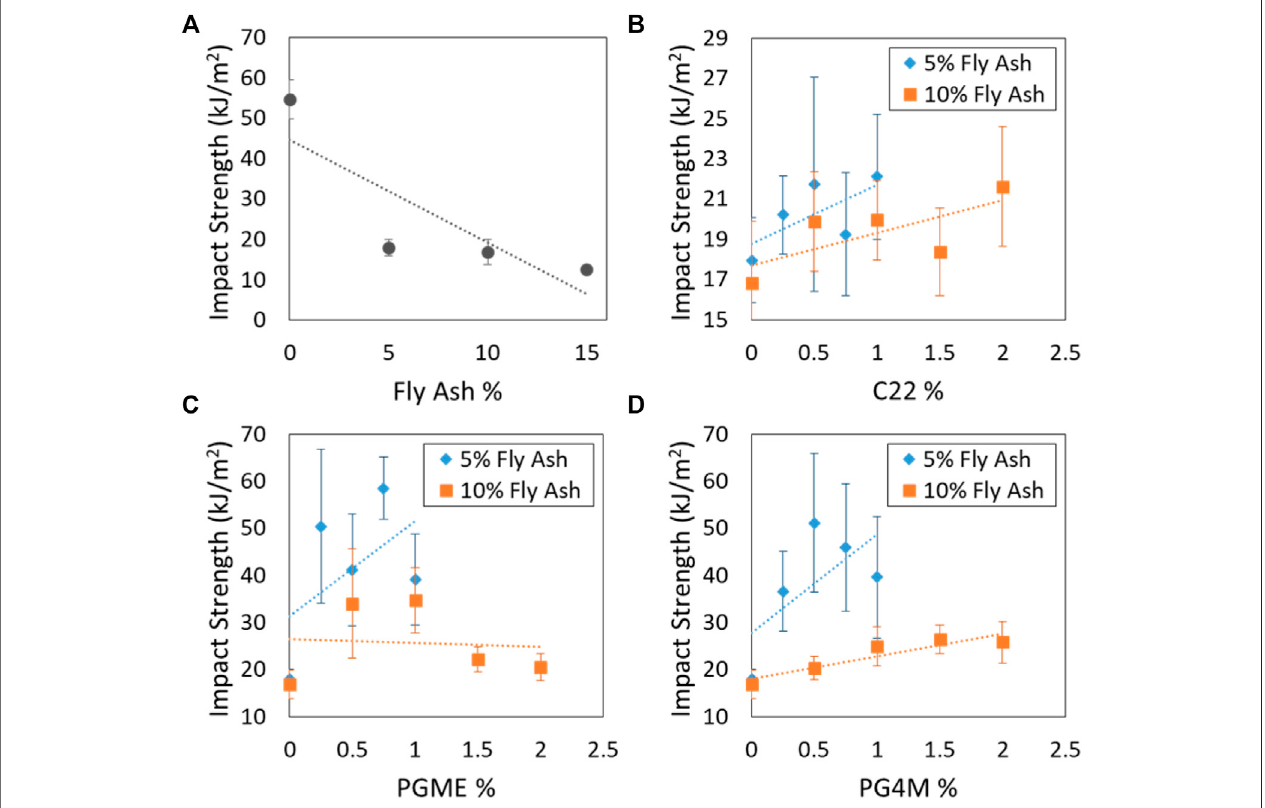
FIGURE 11 | Impact strength calculated from Charpy Impact test results (A) Fly ash blends without compatibilizer, (B) blends with C22, (C) blends with PG4M, (D) blends with PGME.